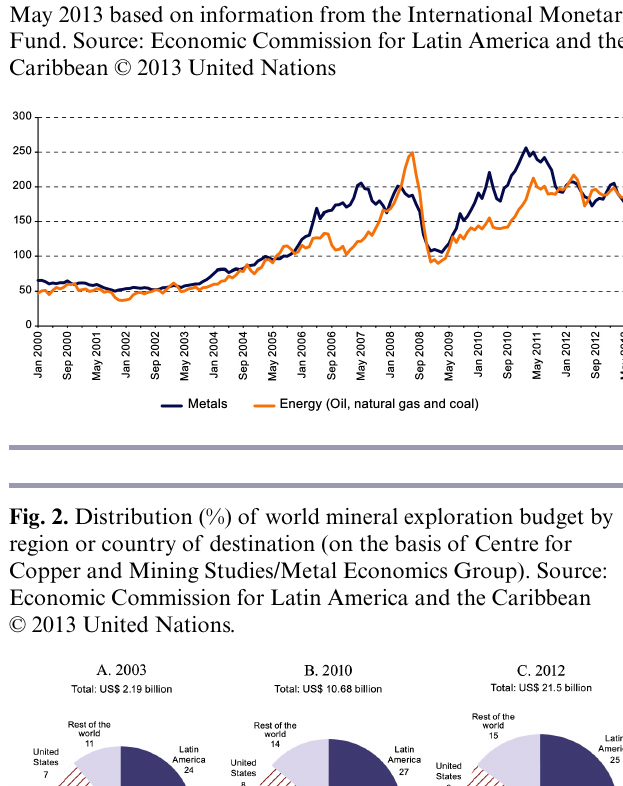
Fig. 1. Index of international commodity prices January 2000 to